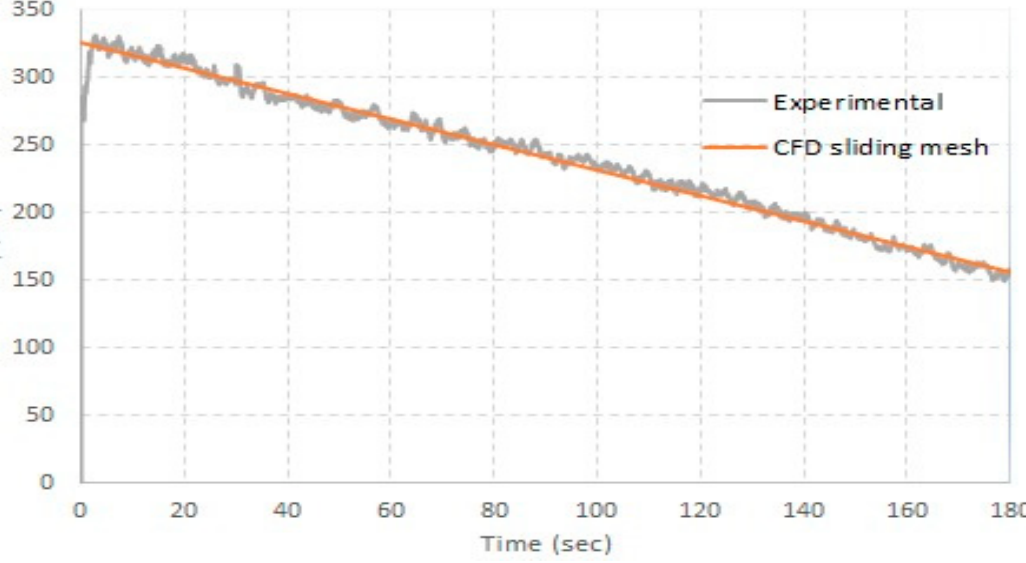
Figure 12. The relationship between the angular velocity (rpm) and the time (s) for the experimental and sliding mesh-CFD models.